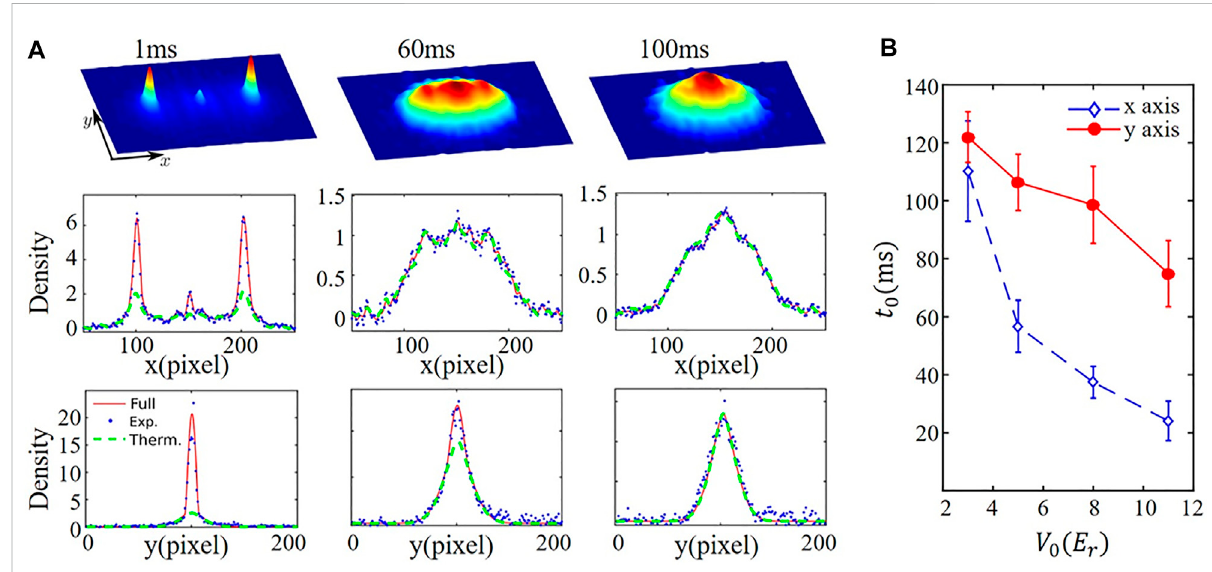
FIGURE 10 (A) Momentum distributions measured at three different holding times t evo = 1, 60, 100 ms, along different directions (with V 0 = 5 E r ). The corresponding distribution along the x -direction is given in the second row with blue dots. The solid red line gives a full fi tting line, while the green dashed line gives the distribution of the thermal component. The third row shows the atomic distribution in the y -direction for images measured by probe 2. (B) The time t 0 for the atoms to lose coherence in lattice and pancake directions with different optical-lattice depths. The blue diamonds are for the x -direction (lattice) by probe one and the dotted points are for the y -direction (pancake). The optical lattice is the 1D